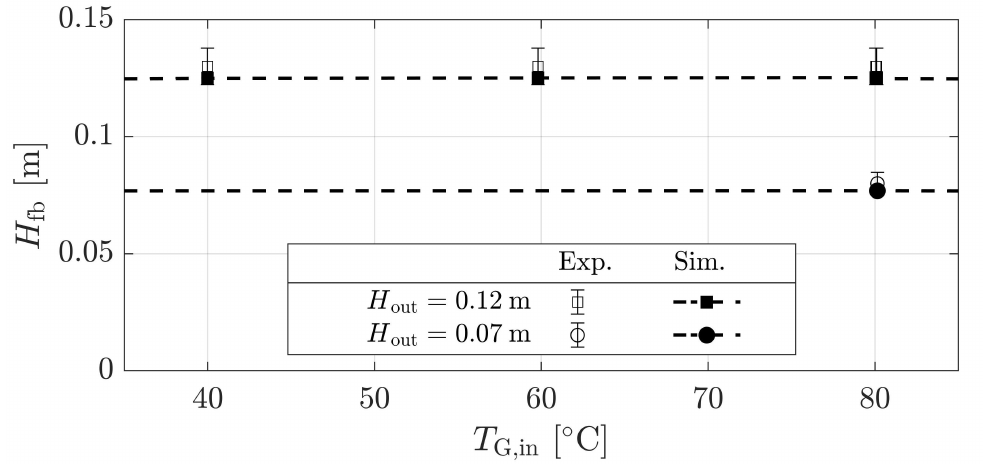
Figure 5. Comparison of bed height ( H fb ), measured in the GF3 lab-scale dryer and model predictions for γ -Al 2 O 3 at different outflow hole heights ( H out